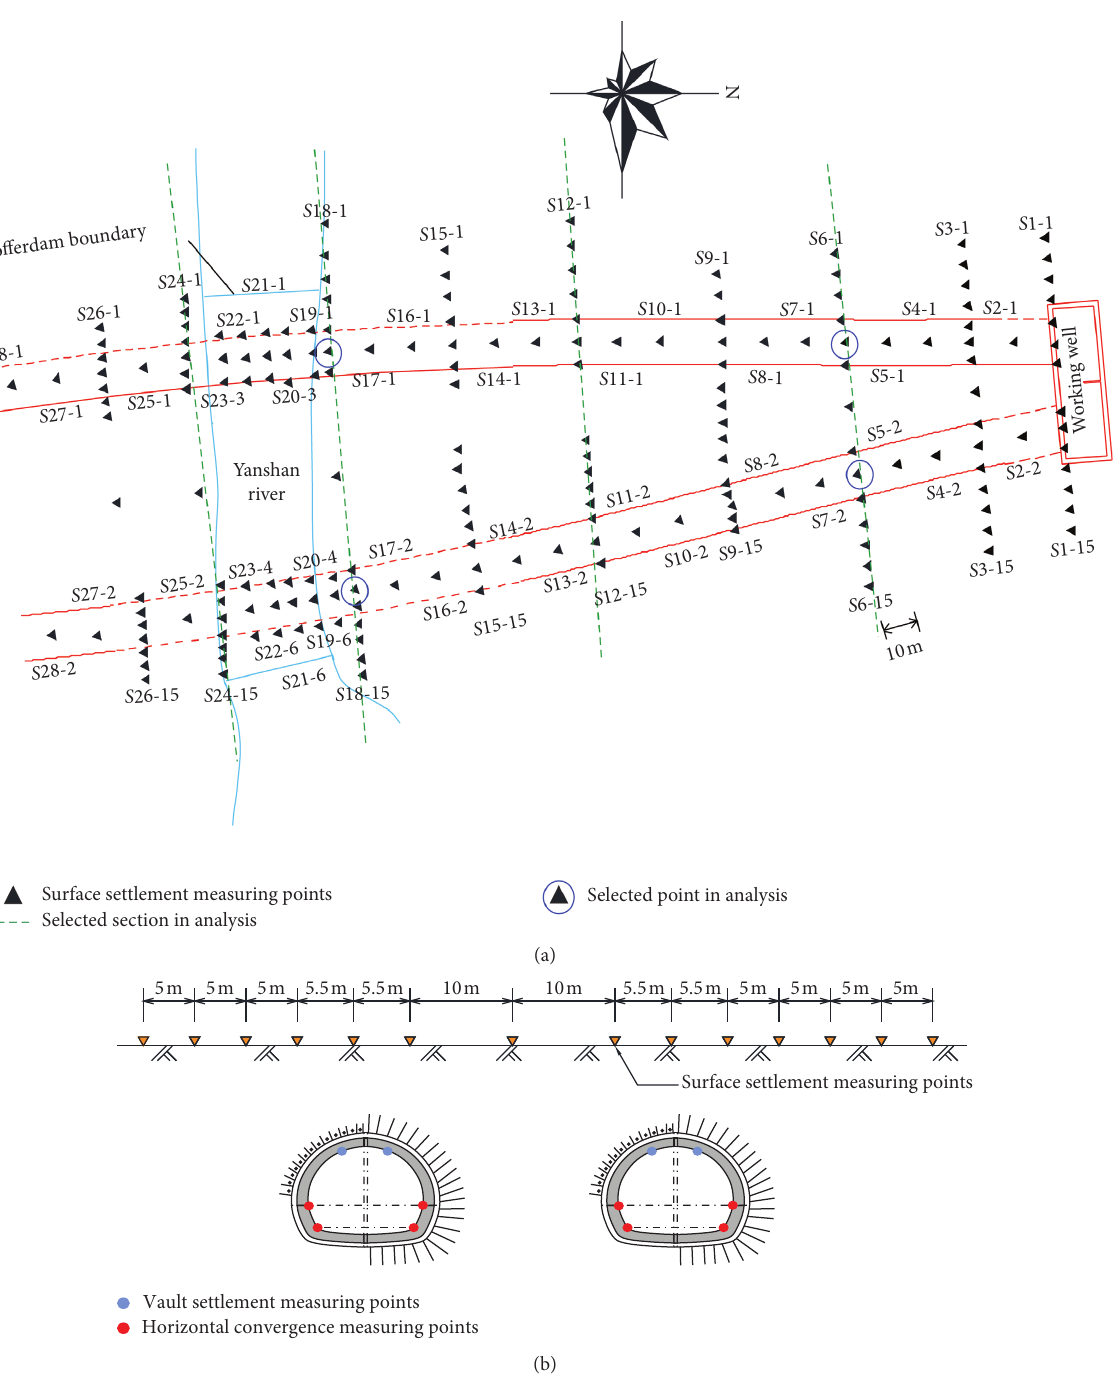
Figure 6: Arrangement of monitoring points. (a) Layout of monitoring points. (b) Typical cross section ( S 6) measuring points’